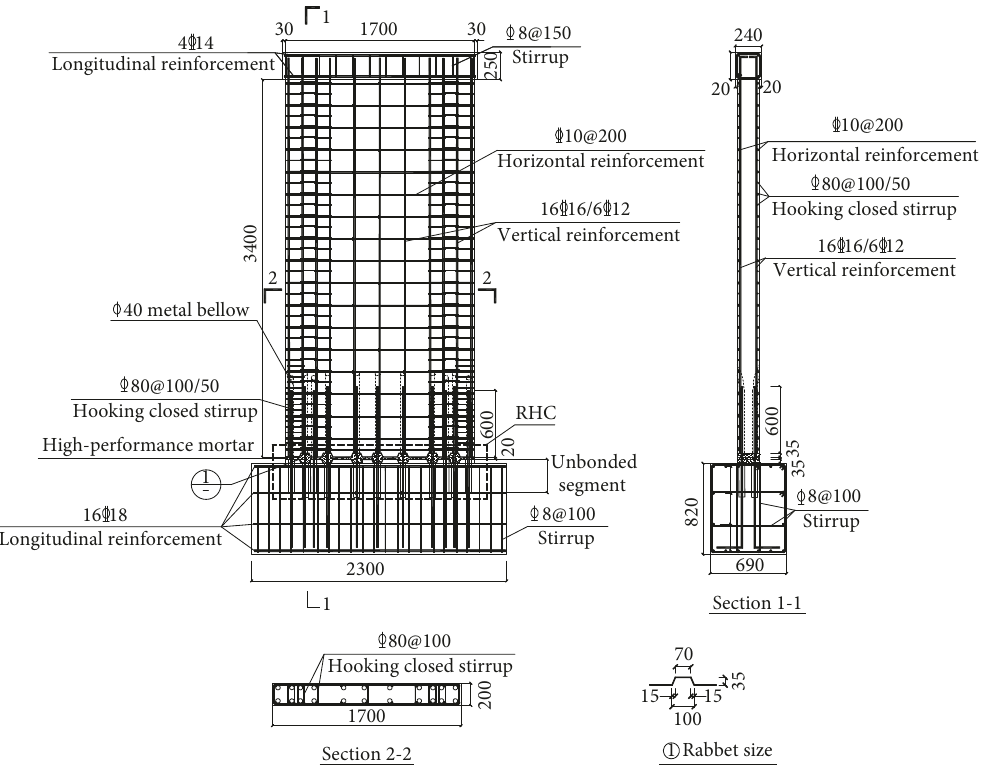
Figure 11: Dimension and reinforcement details of the RHC shear wall specimen (unit: